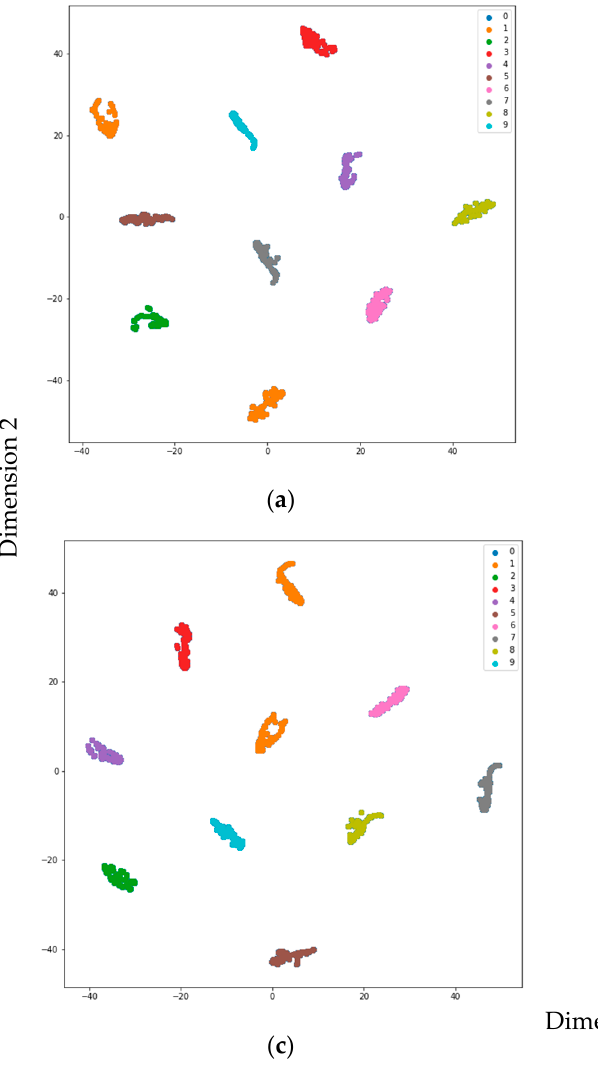
Figure 15. t-SNE under different loads ( a ) 0 HP, ( b ) 1 HP, ( c ) 2 HP, and ( d ) 3 HP.